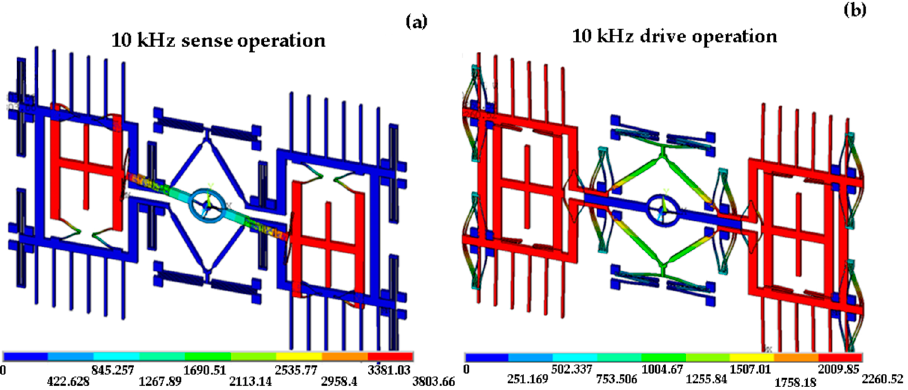
Figure 2. Fundamental operation modes of tuning fork gyroscope obtained by finite element analysis: ( a ) sensing mode and ( b ) driving mode.